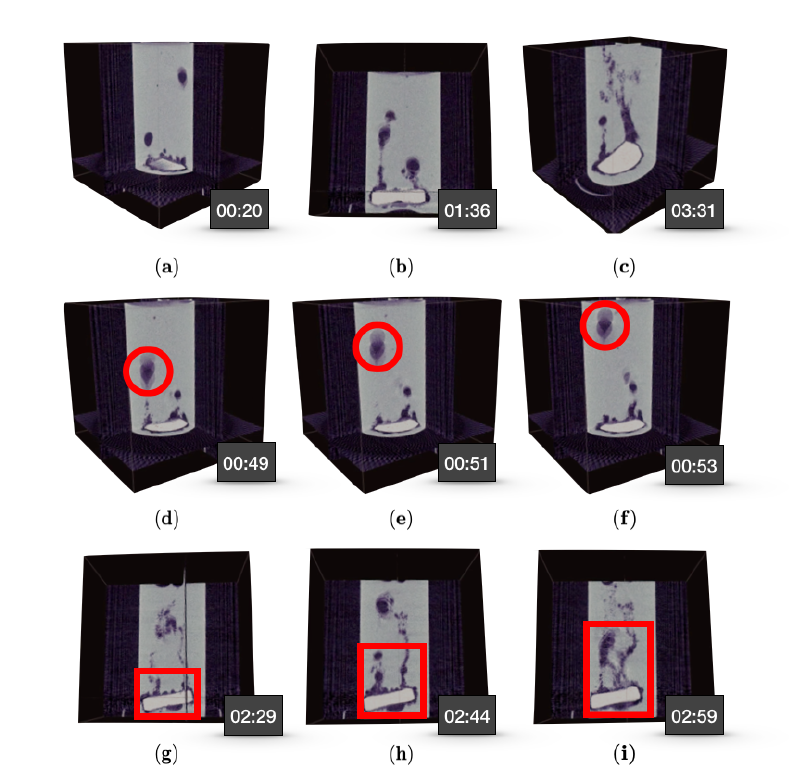
Figure 14. A collection of scenes from the live reconstruction: The top row shows the different interactions the user can perform during the live reconstruction ( a – c ); the middle row focuses on the dynamics of a single bubble travelling on a straight line ( d – f ), and the bottom row highlights the evolution of a trapped gas bubble underneath the tablet ( g – i